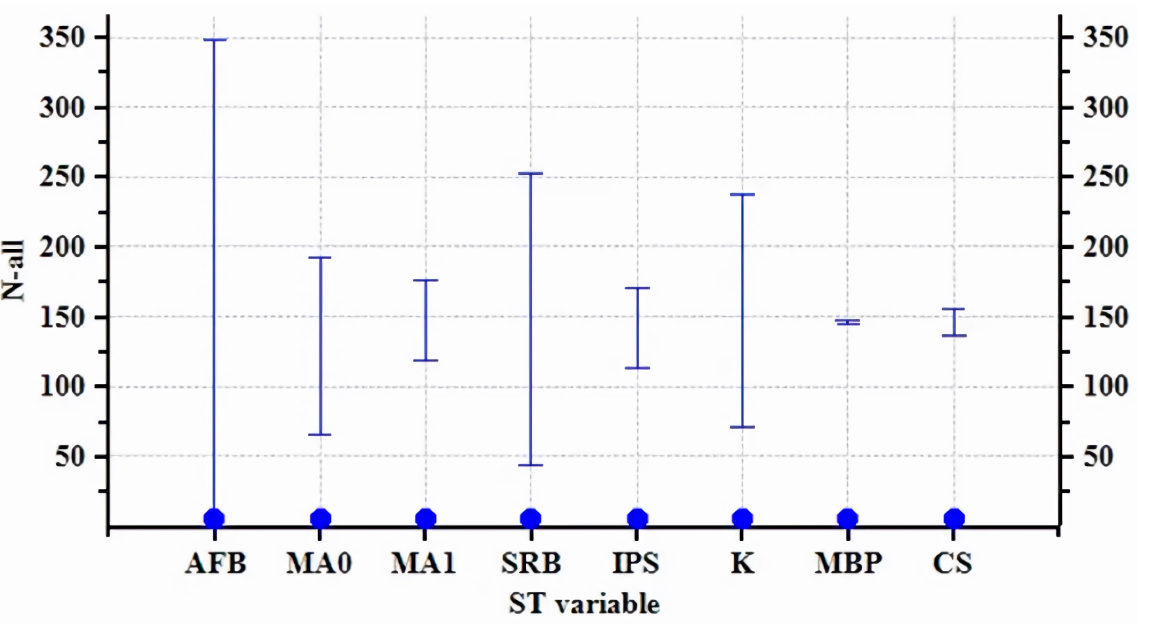
Figure 3. Sensitive analysis to N-all (AFB: adult females breeding; MA0: mortality from age 0 to 1; MA1: mortality from age 1 to 2; SRB: sex ratio at birth; IPS: initial population size; K: carrying ca- pacity; MBP: males in breeding pool; CS: catastrophes severity. A Max-Min plot shown the range of results for each tested variable, averaged across the values of all other tested variables. A point was placed at the result for the base scenario. In a Max-Min plot, the variables with the longest lines had the greatest effect on results).